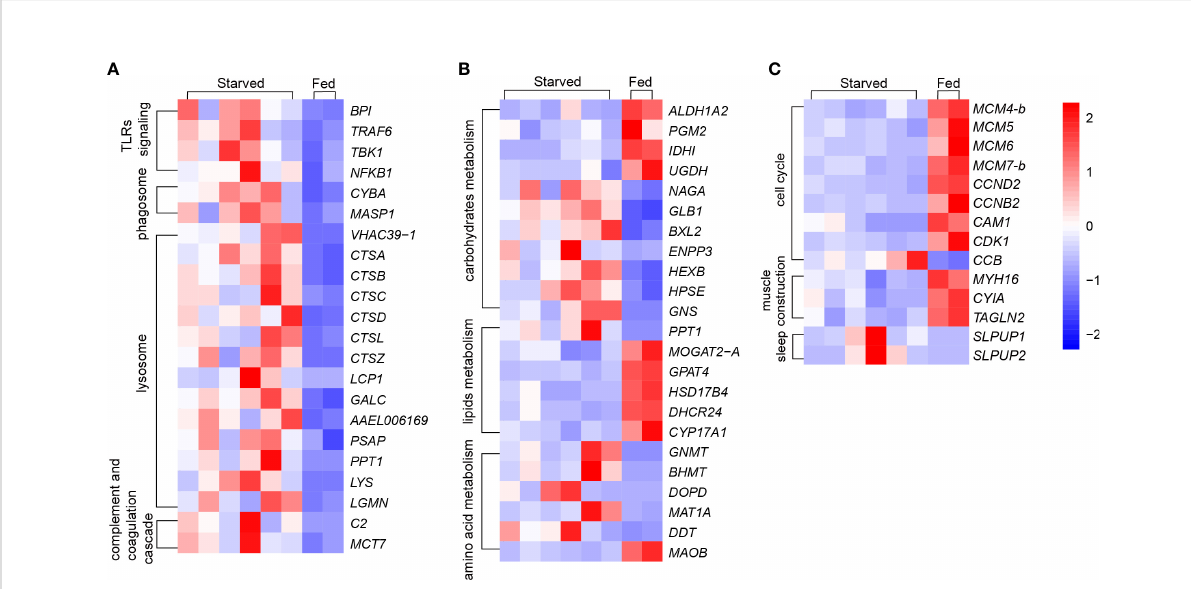
FIGURE 5 Changes of key genes under starvation in CoTS. (A) Immune responses: Toll-like receptors (TLRs) signing, phagosome, lysosome and complement and coagulation cascade. (B) Metabolism responses of carbohydrates, lipids and amino acids. (C) Other key changes of cell cycle, muscle construction and